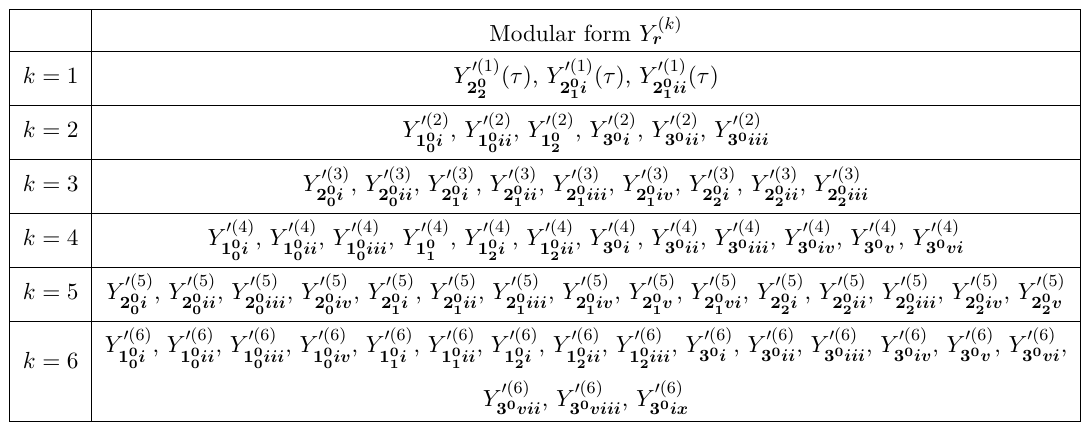
Table 8 . Summary of modular forms of level N = 6 up to weight 6 and the decomposition under the finite group T 0 , where the subscripts denote the transformation property under the T 0 modular